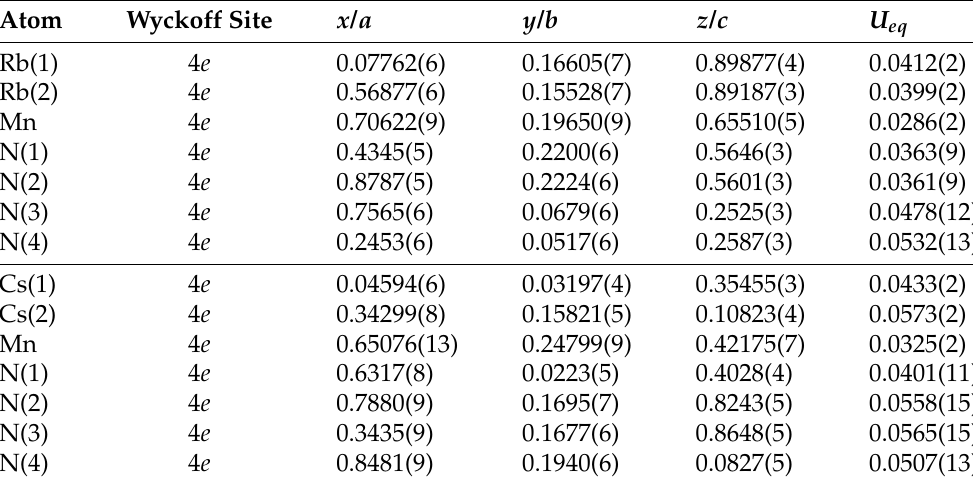
Table 2. Fractional coordinates and isotropic displacement parameters U eq (in 10 4 pm 3 ) for HT-